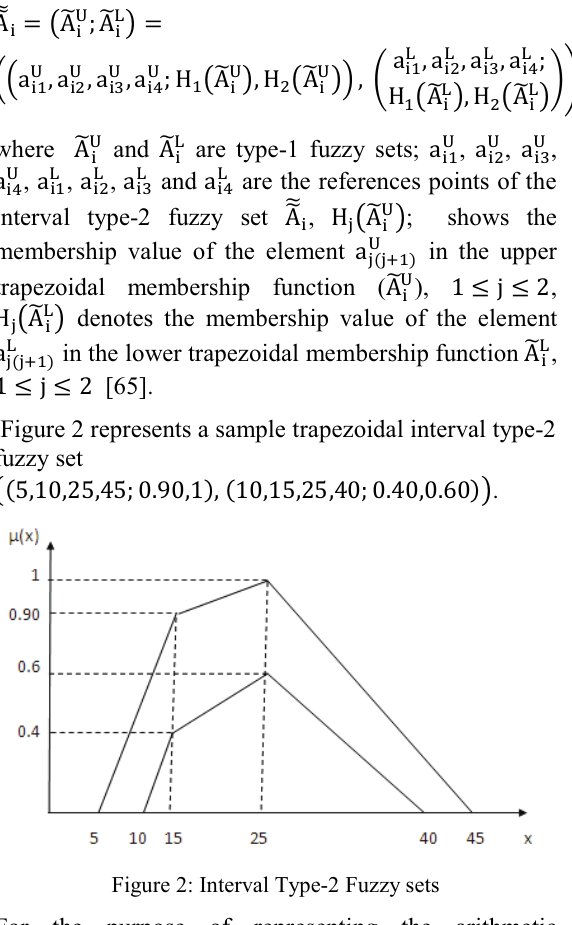
Figure 2: Interval Type-2 Fuzzy sets For the purpose of representing the